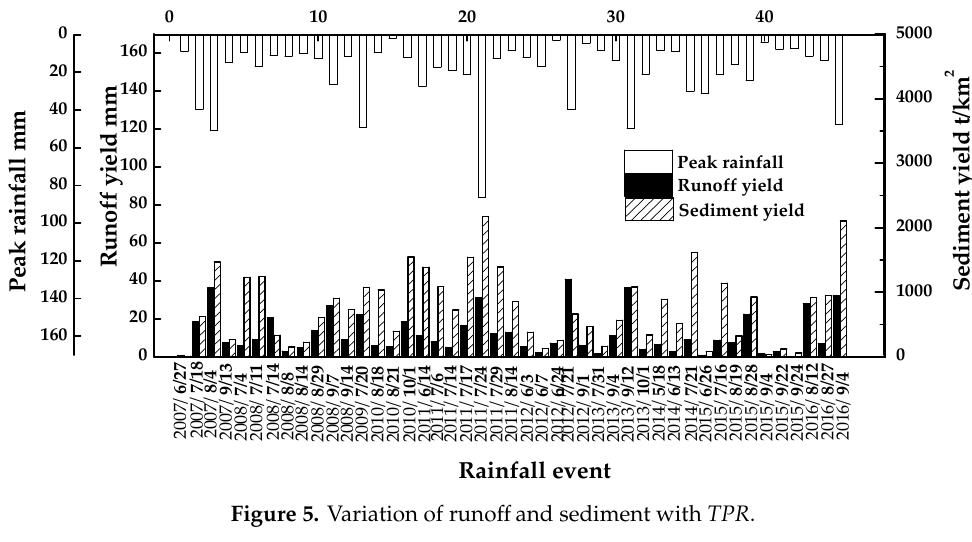
Figure 5. Variation of runoff and sediment with TPR .